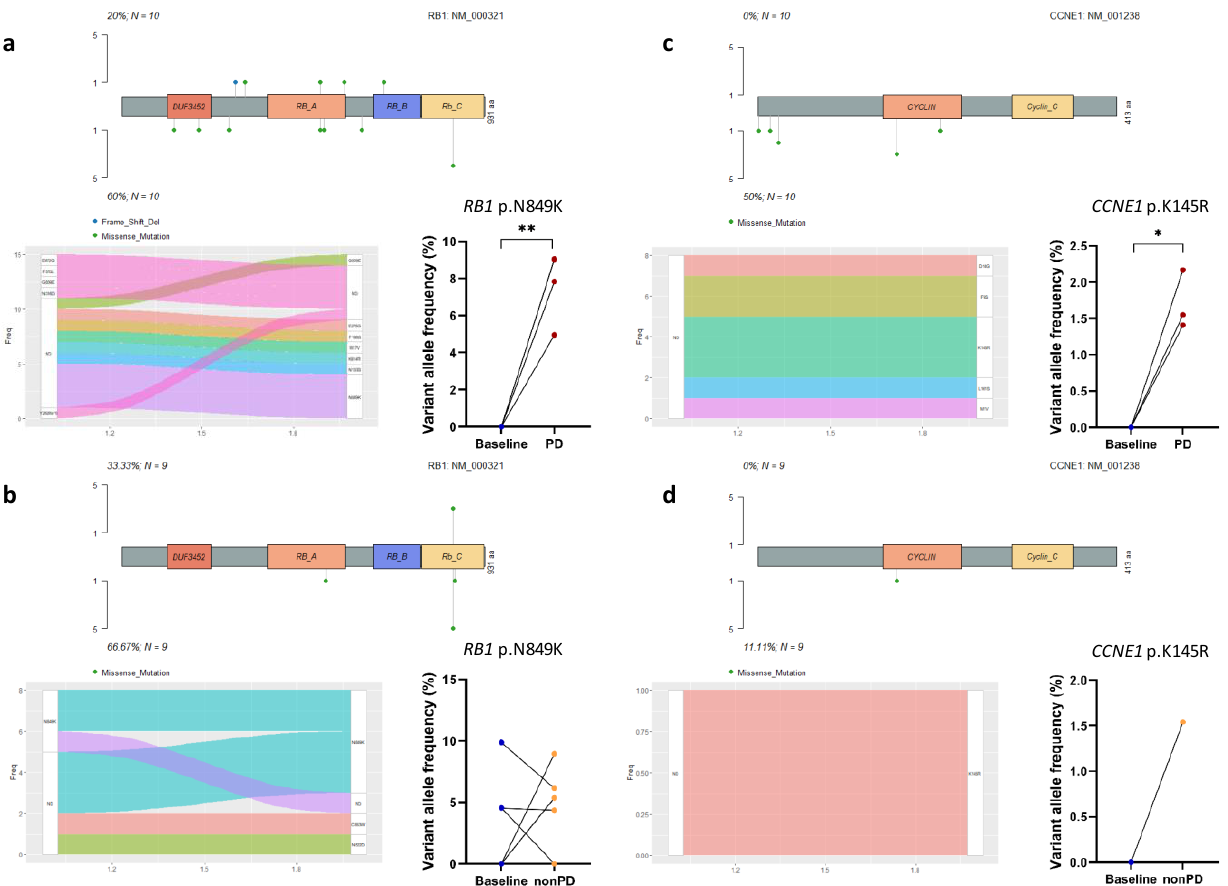
Figure 3. Changes in individual mutations in cell cycle pathway genes and changes in variant allele frequency of a given mutation from baseline to follow-up as determined by analyzing paired samples. ( a , b ) show the changes in RB1 mutations in baseline-PD pairs or baseline-nonPD pairs. ( c , d ) show the changes in CCNE1 mutations in baseline-PD pairs or baseline-nonPD pairs. PD: progressive disease; ND: not detected. * represents p < 0.05; ** represents p < 0.01. The Notch pathway is involved in embryological development and promotes prolifer- ative signaling, and FBXW7 is a negative regulator of the Notch pathway [29]. In this study, we found more patients with acquired FBXW7 mutations in the PD samples (6/10) than in the nonPD samples (4/9, p = 0.656), as compared to corresponding baseline samples. The FBXW7 N80D amino acid substitution was recurrently detected in these samples, exhibiting significantly increased VAFs in the PD samples when comparing to paired baseline samples ( p = 0.012, Figure 4c), whereas the difference was not significant in the baseline versus nonPD pairs comparison ( p = 0.522, Figure 4d). Intriguingly, more (4/7, 57%) non-IBC patients (No. 2, 4, 6, 12) acquired this FBXW7 mutation in their PD samples than IBC patients (No. 8, 11%, p = 0.106), whereas two (No. 1, 10) out of three IBC patients with this mutation at baseline lost it after treatment. This result has never been reported by any of previous studies exploring molecular mechanisms of resistance to the CDK4/6